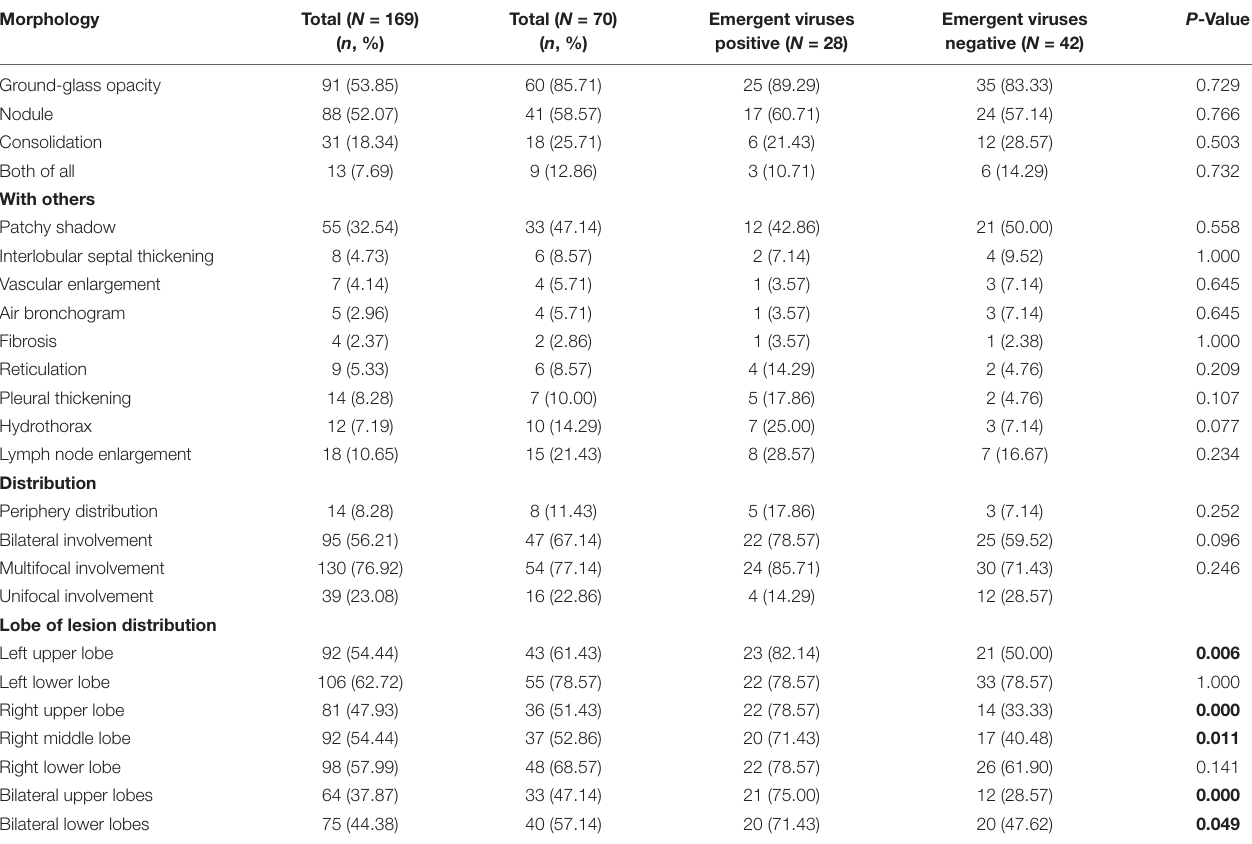
TABLE 4 | Initial chest CT findings of SARS-CoV-2-Negative community acquired pneumonia patients. Morphology Total ( N = 169)